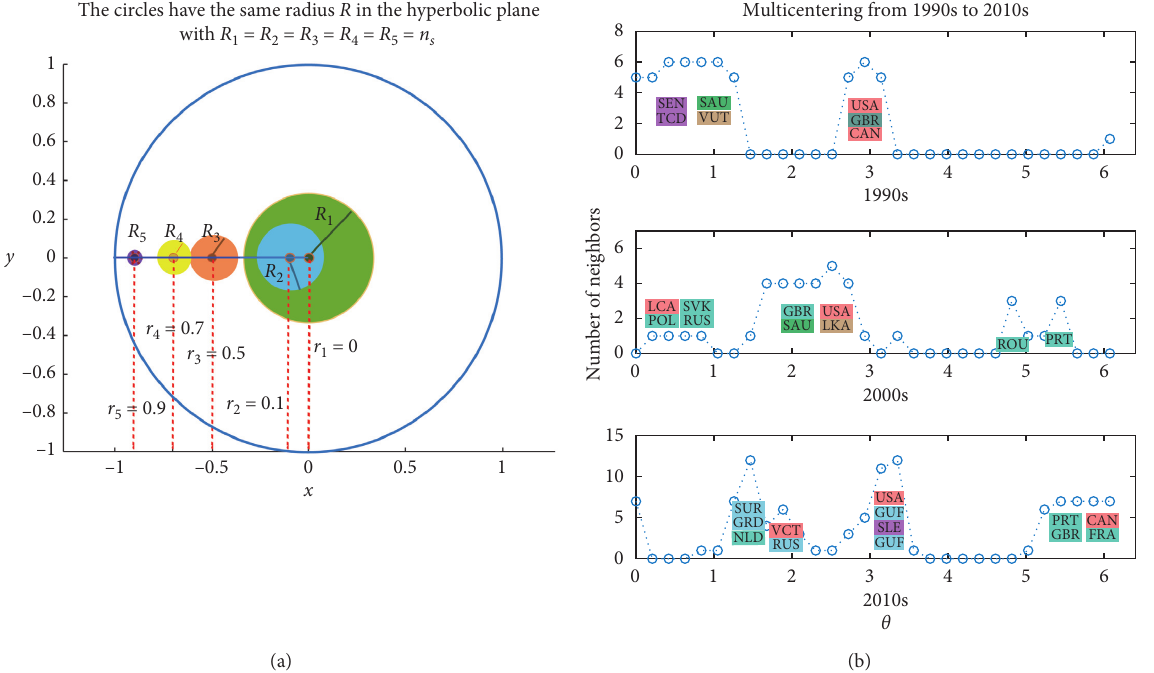
Figure 6: Angular density in hyperbolic plane which could describe the aggregation of countries and the multicentering characteristics of global migration networks. (a) Definition of neighborhood. (b) Angular